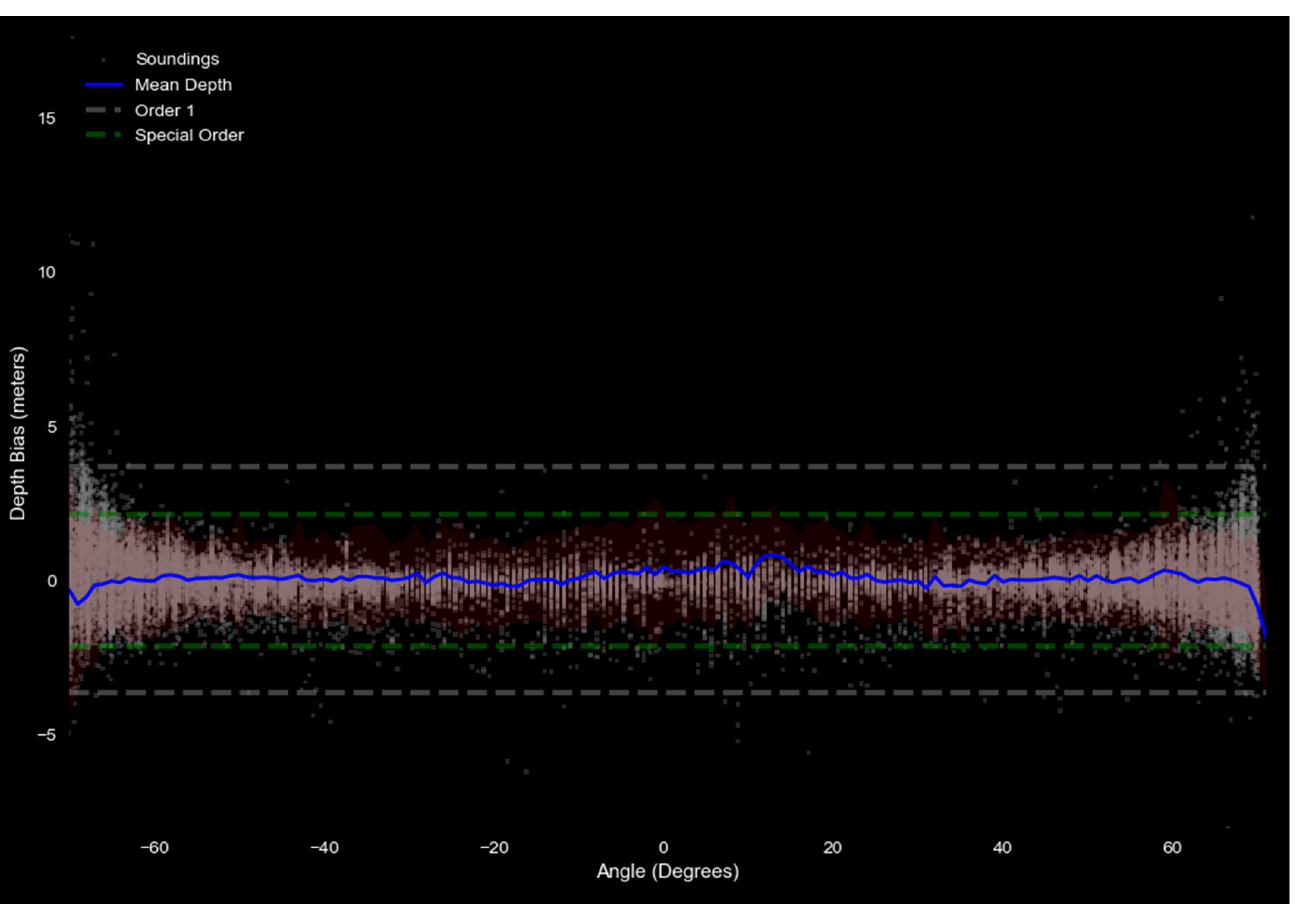
Figure 13. Kluster Accuracy Test result, showing the depth bias between the accuracy test lines in 70–100 kHz, medium mode, and the reference grid, plotted as function of beam angle. Comparisons to IHO Order 1 and IHO Special Order are shown as the horizontal dotted lines.